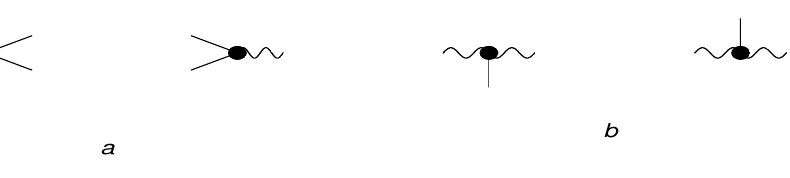
Figure 6 . The interaction